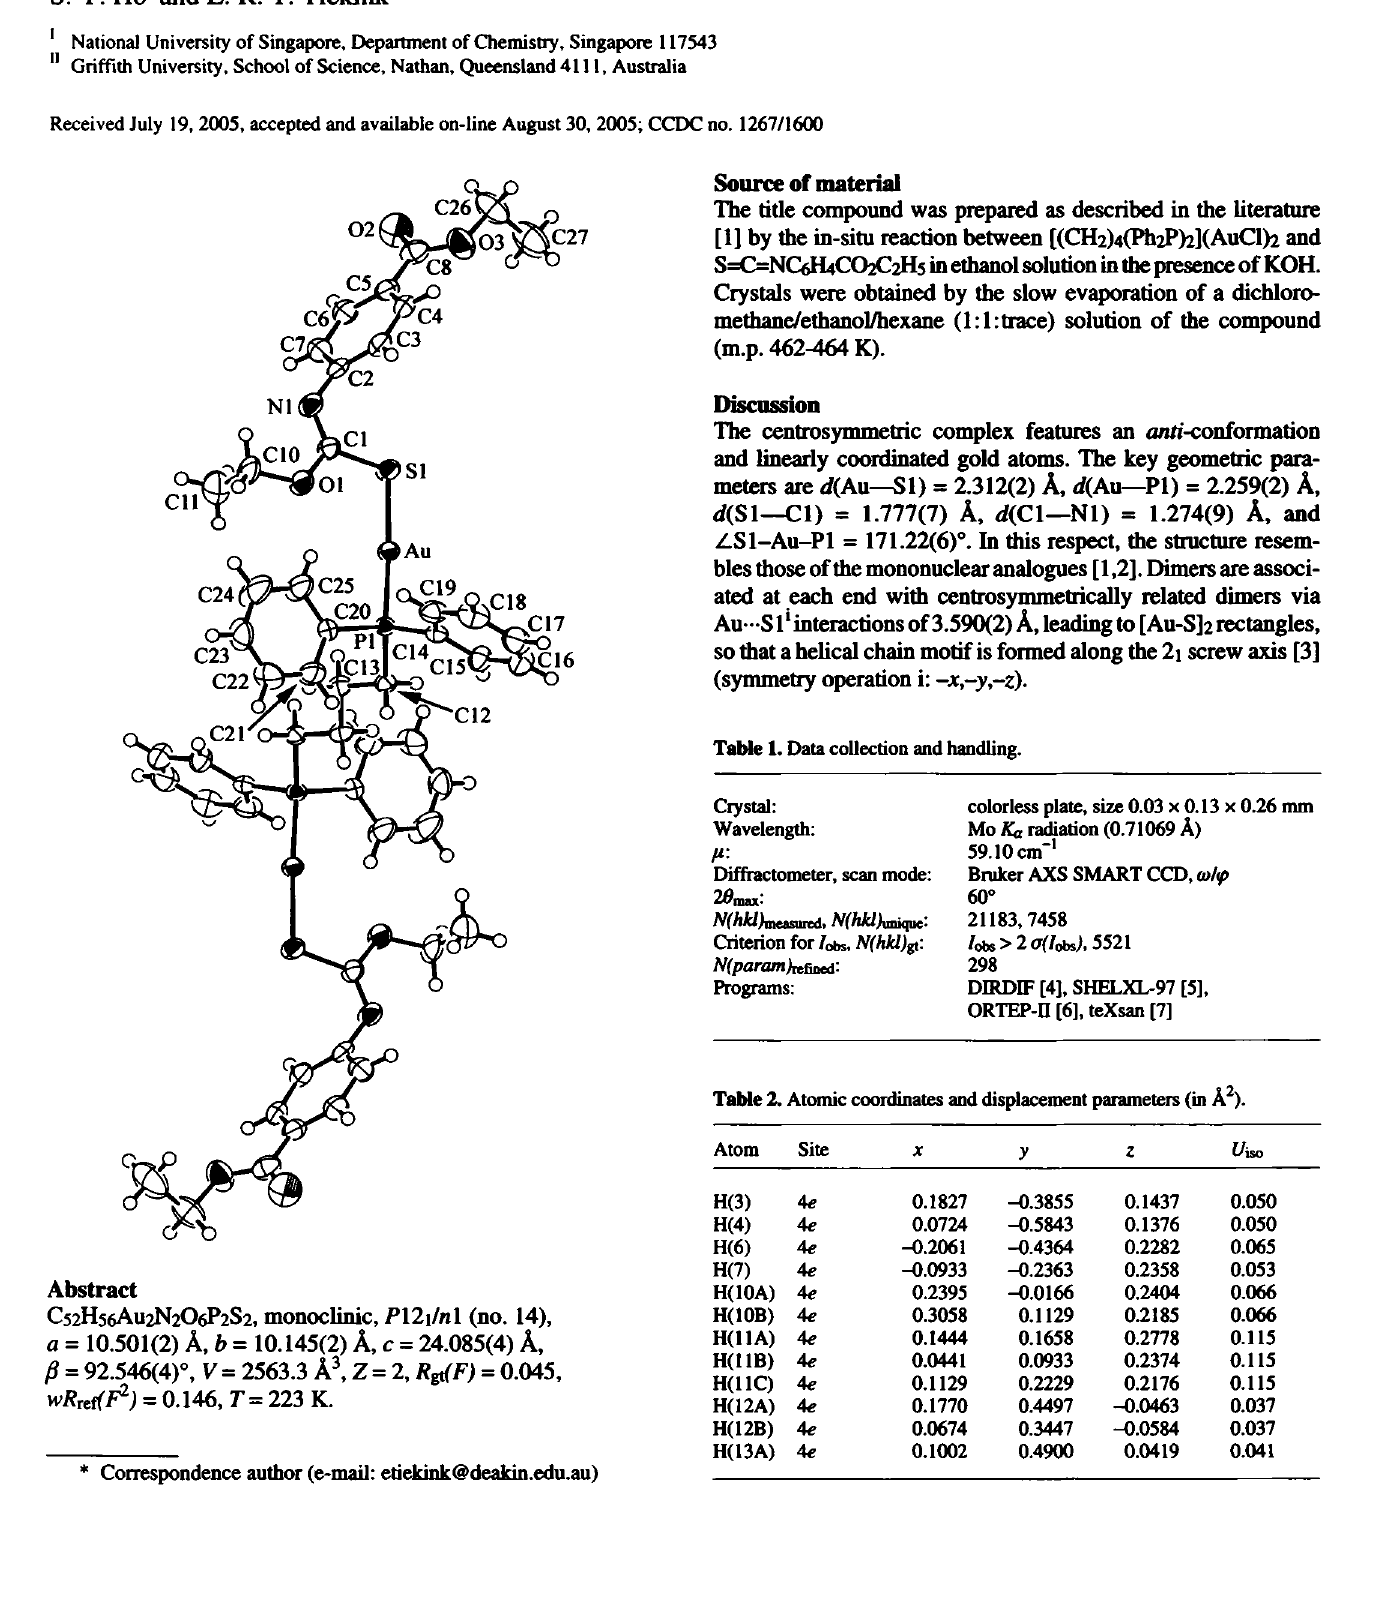
Table 2. Atomic coordinates and displacement parameters (in A 2